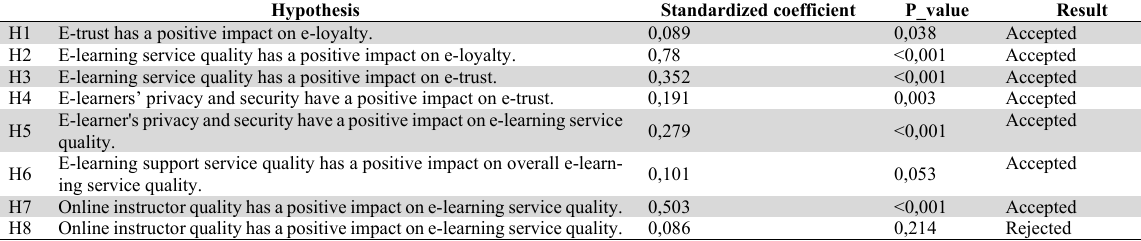
Hypotheses’ testing result